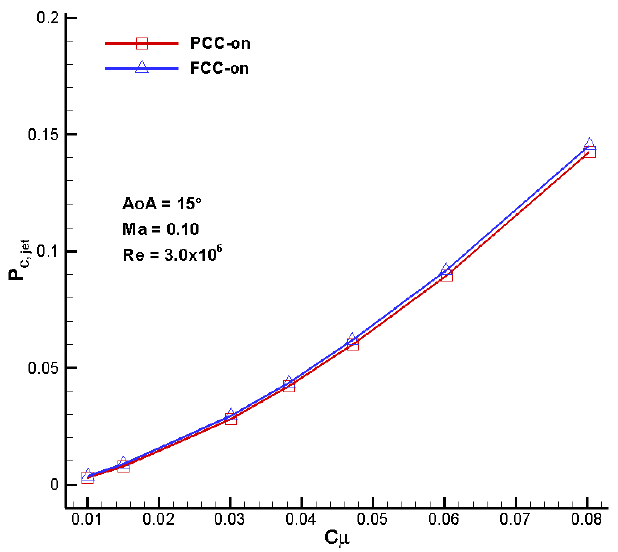
Figure 15. Power coefficients versus jet momentum coefficient.